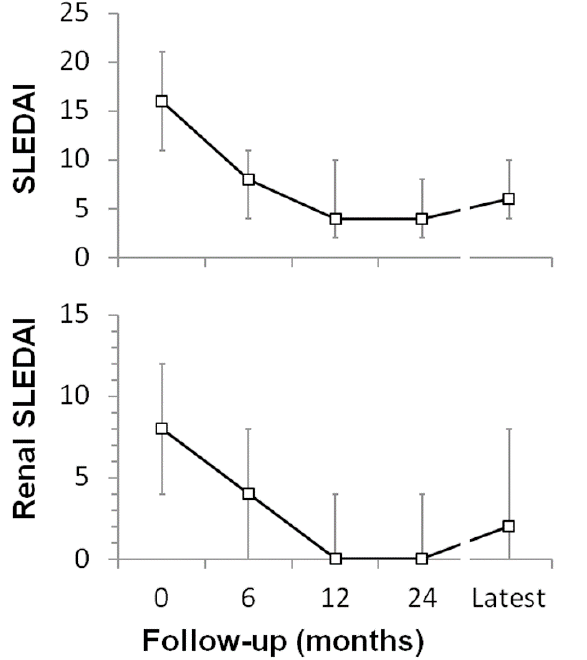
Figure 4. Disease activity scores over time in males with childhood-onset SLE on therapy. The Systemic Lupus Erythematosus Disease Activity Index (SLEDAI) score and Renal-SLEDAI score both were calculated for all patients ( n = 41 at disease onset, n = 34 at 6 m, n = 29 at 12 m, n = 29 at 24 m, and 37 at latest follow-up). Data is shown as median score and error bars represent the intra-quartile ranges (IQR). Latest follow-up was a median of 3.4 years (IQR